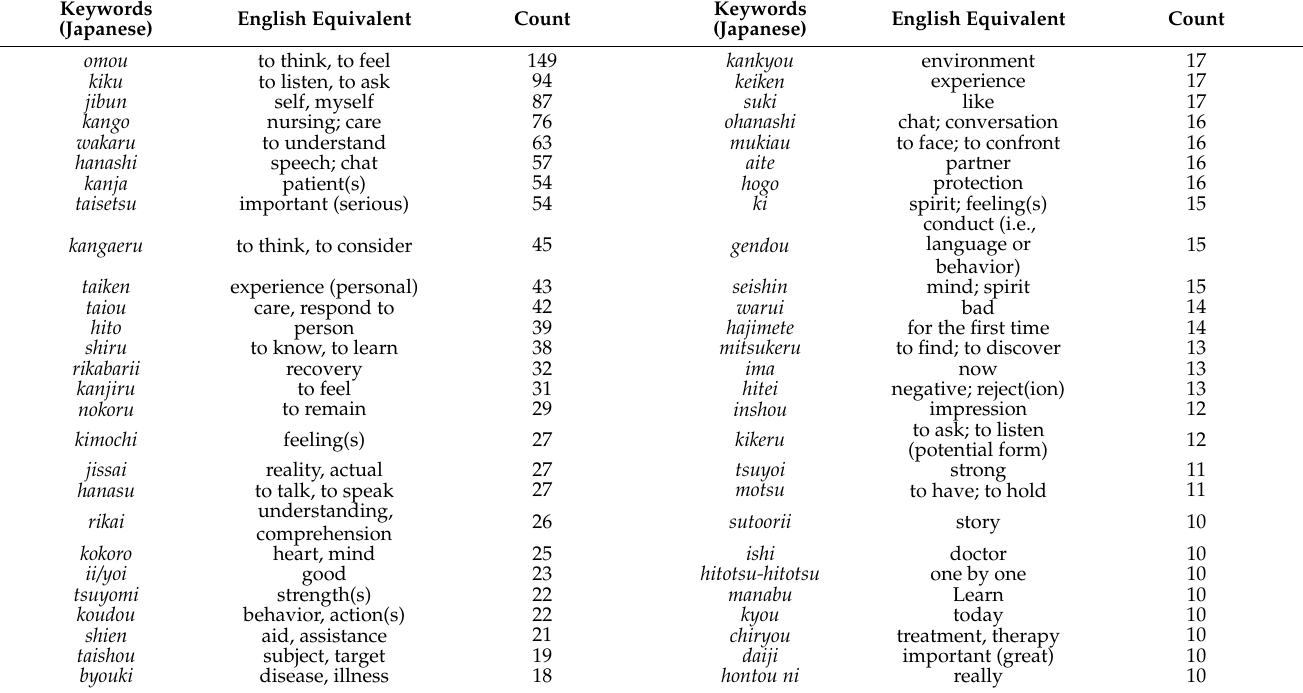
Table 2. List of most frequently occurring words ( n ≥ 10).